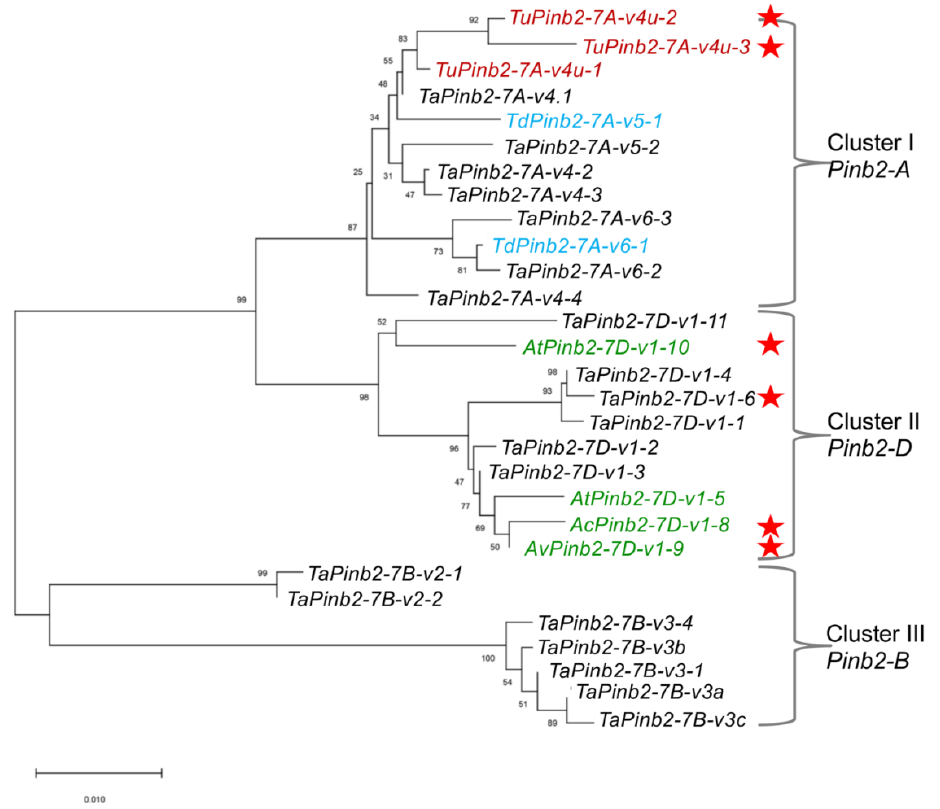
Figure 5. Phylogenetic tree of Pinb2 variants highlights that these sequences are clustered according to the loci where they are located. Phylogeny of Pinb2 alleles was constructed using the neighbor-joining method with 1000-time bootstrap and the substitution model of Kimura 2. Di ff erent Pinb2 alleles from di ff erent Triticeae species in this study are labeled in di ff erent colors. The Pinb2 alleles from durum wheats were labeled in blue color, bread wheat in black, T. urartu in red, Ae. tauschii in green. The new alleles identified in this study are indicated using red